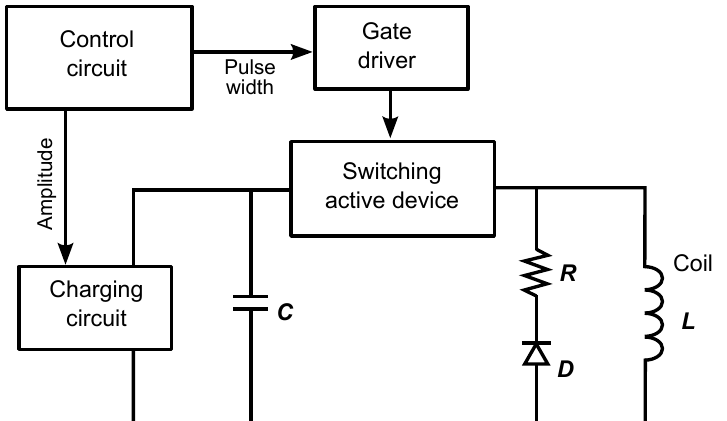
Figure 4. Basic circuit of TMS